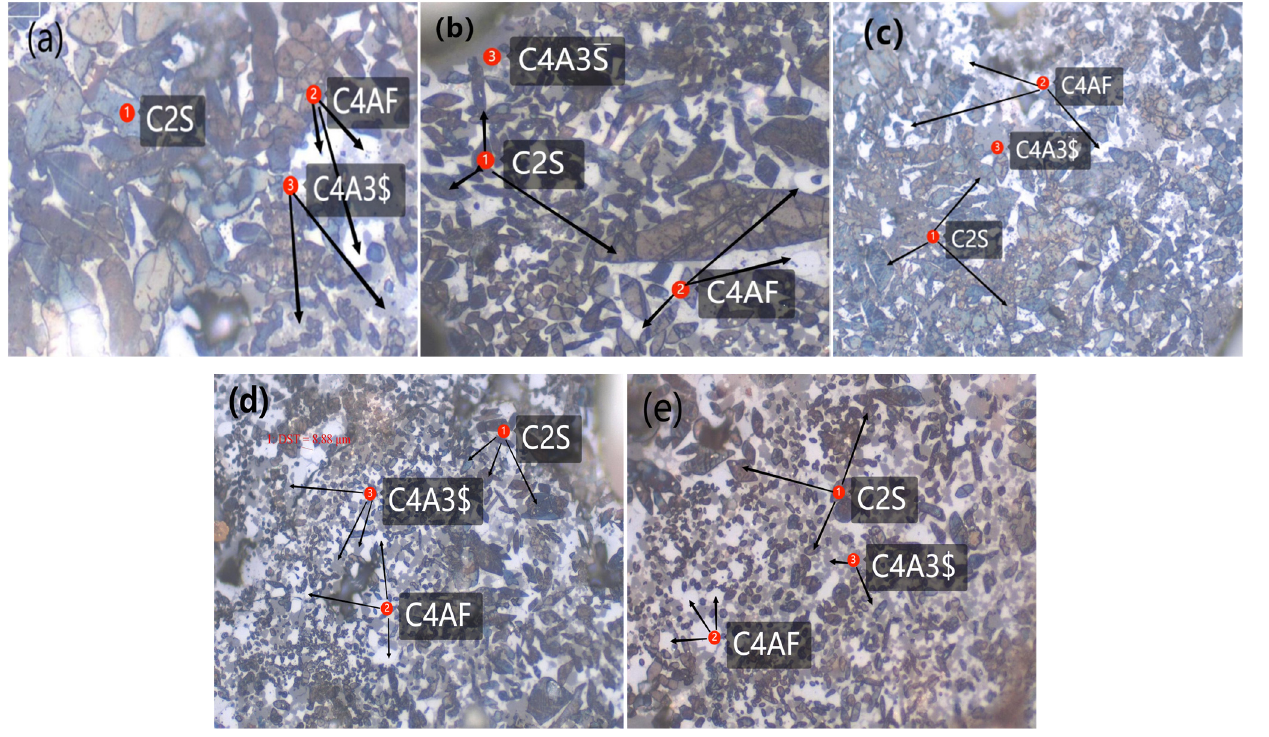
Figure 3. Petrographic images of HBSC clinker ( a ) GF-1 × 400, ( b ) GF-2 × 400, ( c ) GF-3 × 400, ( d ) GF-4 × 400, and ( e ) GF-5 × 400.